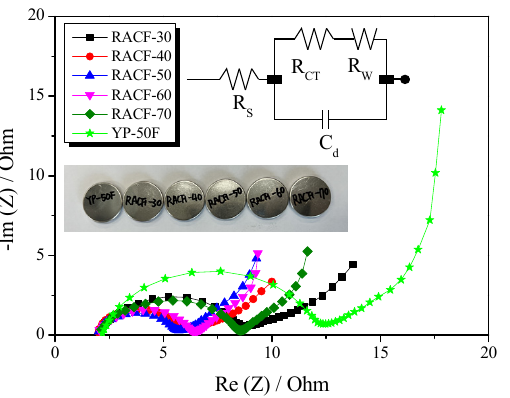
Figure 9. Nyquist plots of RACF obtained using different various activation conditions. The inset shows its equivalent circuit. Table 2. Values of equivalent circuit parameters from the fitting of the impedance spectra in Figure